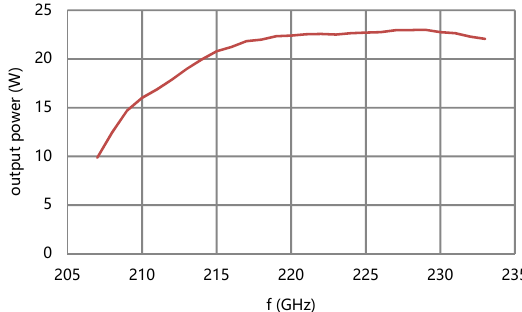
Figure 10. Saturation output power of the circuit.